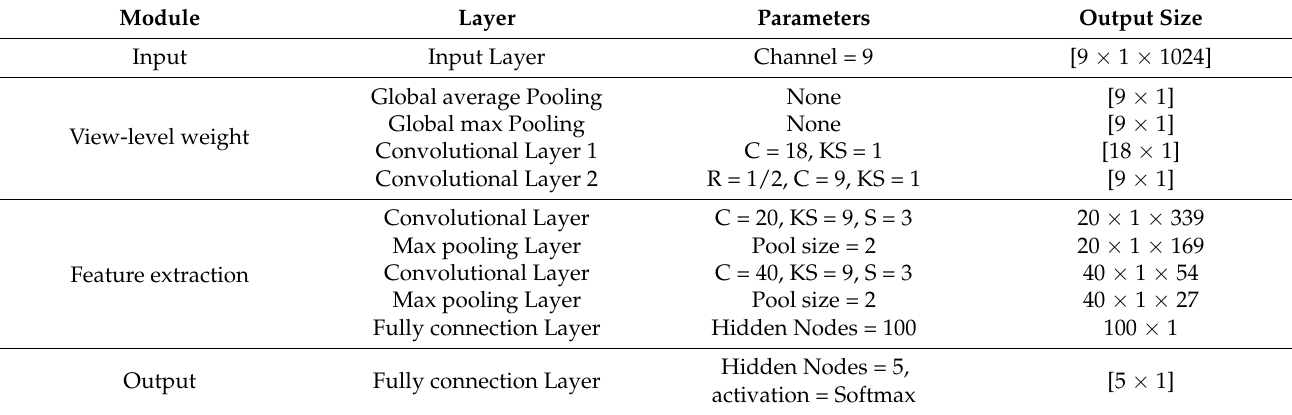
Table 3. Module parameters setup of of CAM_MCFCNN model.